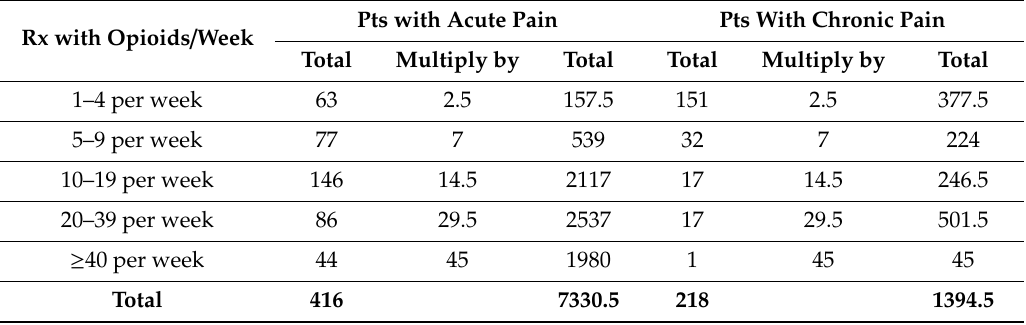
Table 5. Number of patients treated with opioids per week for acute and chronic